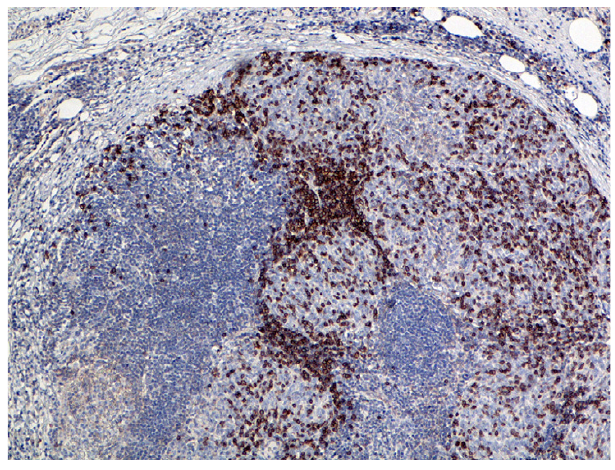
Figure 17 (B-SA, anti-CD99, × 200): Micronodular thymoma. Note strong expression of CD99 in intratumoral lymphocytes.